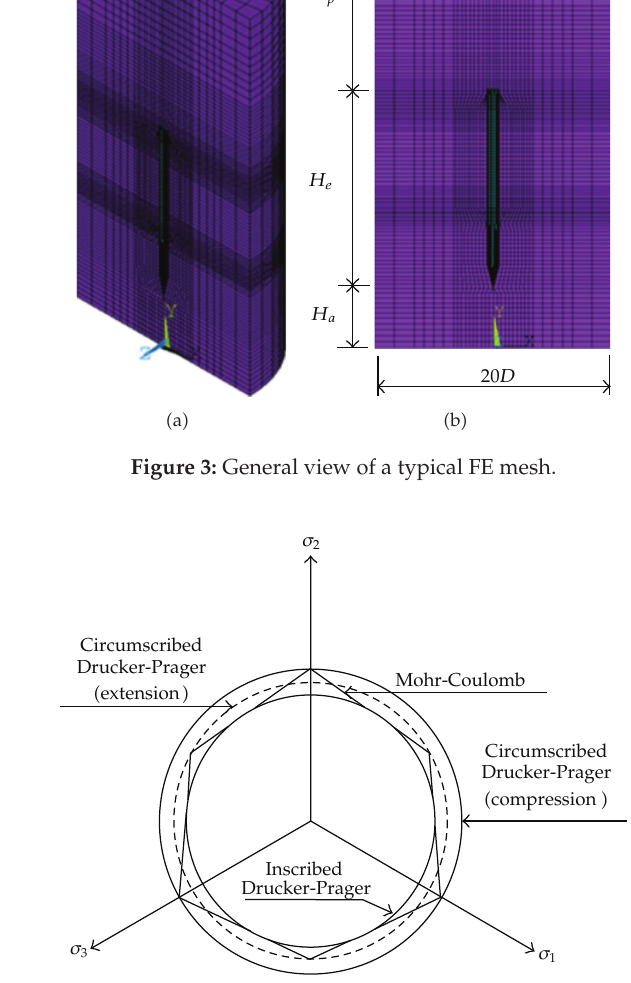
Figure 4: Drucker-Prager and Mohr-Coulomb yield surfaces in the deviatoric